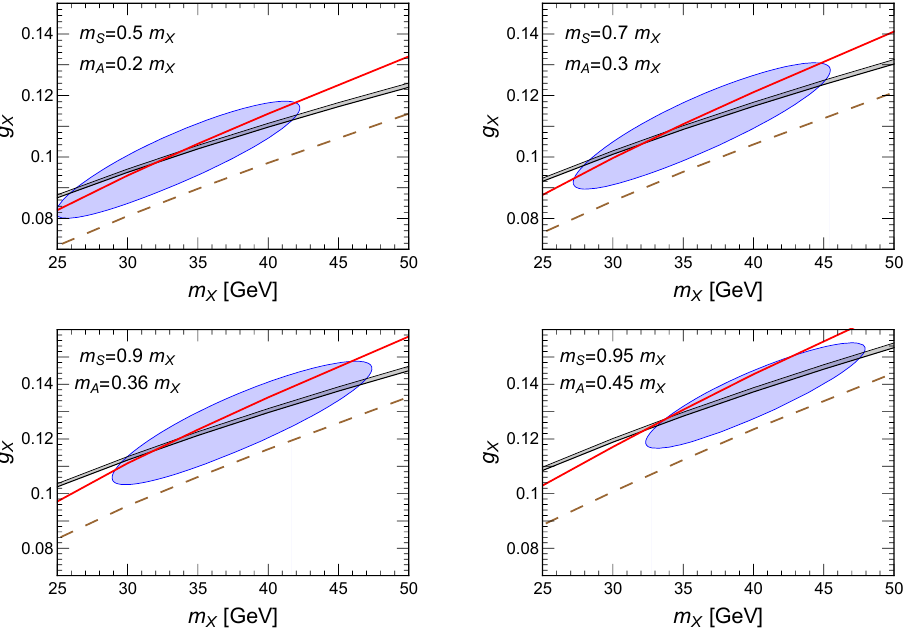
Figure 5 . Same as (cid:12)gure 4, but in the ( m X ; g X ) plane, where the blue shaded region delineated with the blue line provides a good (cid:12)t to the GC gamma-ray data with p -value (cid:21) 0 :